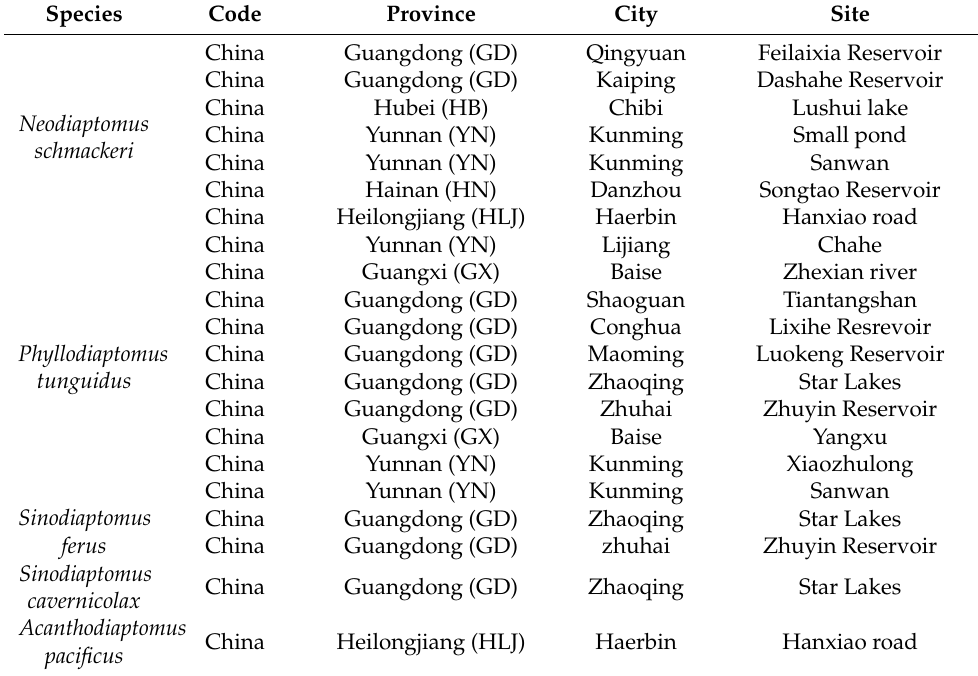
Table 1. The summary of thirteen sampling locations in this